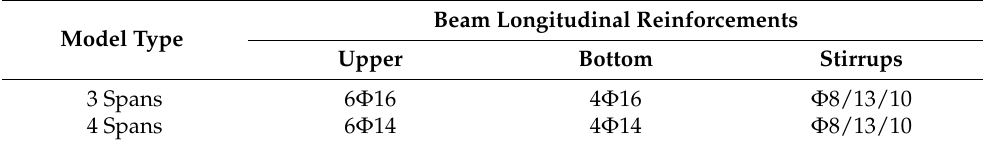
Table 3. Selection of beam reinforcements according to the general rules of TBEC-2019 (Section 17). Beam Longitudinal Reinforcements Model Type Model Type Upper Bottom